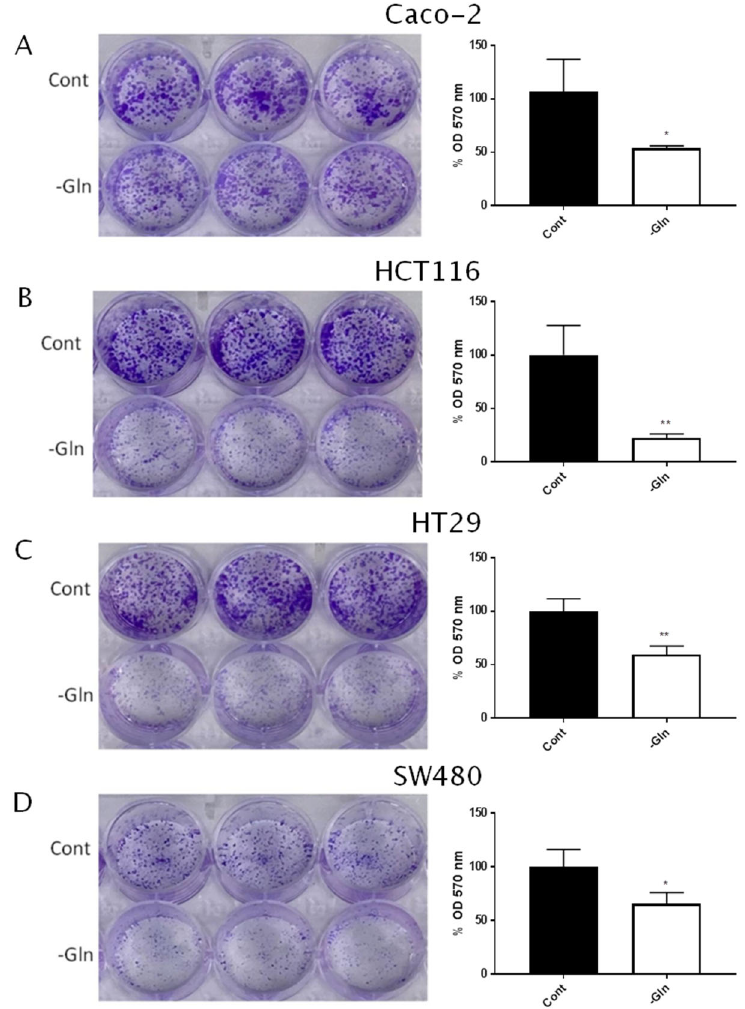
Figure 2. Glutamine deprivation reduced the colony ‐ forming ability of colorectal cancer cells (( A ) Caco ‐ 2, (B)HCT116, ( C ) HT29, ( D ) SW480). Cells were seeded in 6 ‐ well plates (500–1000 cells/well) and left to grow for 48h in a complete medium. Cells were then shifted to glutamine ‐ deprived medium ( ‐ Gln) or to complete medium (Cont) and were fixed with crystal violet after 6–10 days. Optical density (OD 570 nm) of solubilized crystal violet was used to evaluate cell colony formed. Data are presented in histograms as a percentage of control. The experiment was performed in triplicate and represented mean ± SD ( n = 3, * p < 0.05, ** p < 0.005).